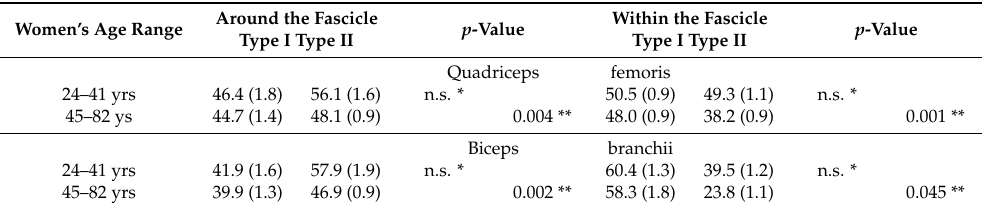
Table 2. Associations of the number of both muscle fiber types within and around the fascicle in the sample of postmortem